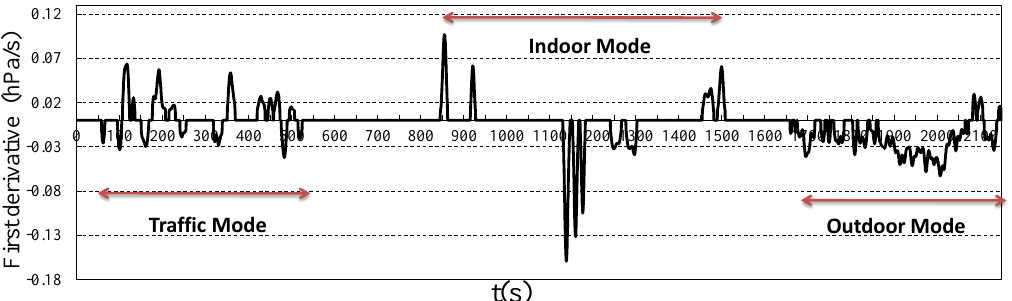
Figure 6. The differential of the barometer readings for different moving modes.